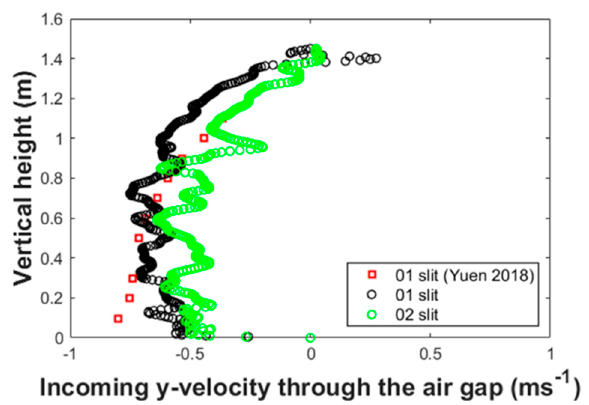
Figure 3. Numerical prediction of incoming y-velocity through the air gap, compared with that generated from prior study.